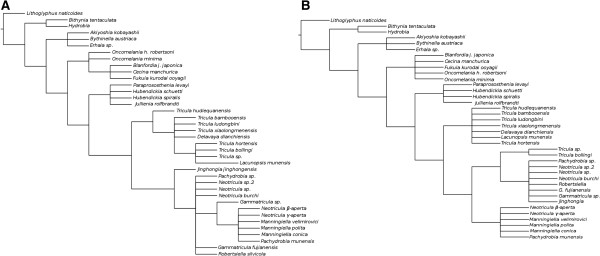
Phylogenetic trees consistent with alternative phylogeographies for the Pomatiopsidae. A. Phylogeny consistent with the Tibet hypothesis. Taxa are generally considered to be more derived (i.e., to show progressively more apomorphic character states) as one moves away from Dali in Yunnan, following suggestions in the literature [10]. Taxa are grouped into clades according to hypothesized tracts of dispersal and isolating geographical barriers. B. Phylogeny consistent with the Hunan hypothesis (following Table 1).